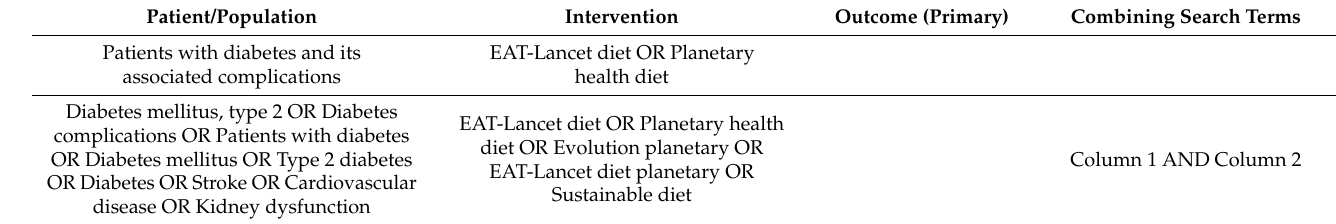
Table 1. Search terms using the PICO